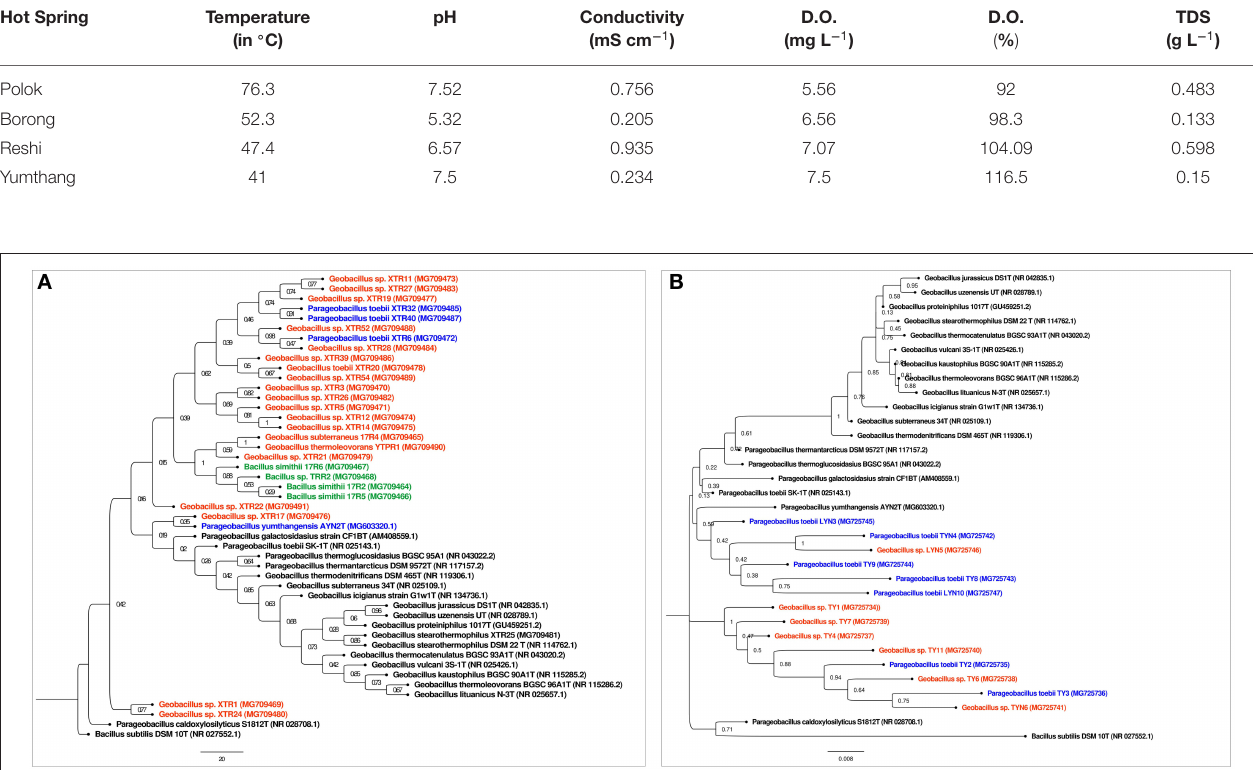
TABLE 2 | Physical Parameters of Polok, Borong, Reshi and Yumthang Hot Springs.